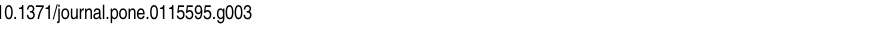
Fig. 3. Configuration of three-point bending test. The configuration promoted a stable three-point contact where the tibia would be able to lengthen along diaphyseal axis.